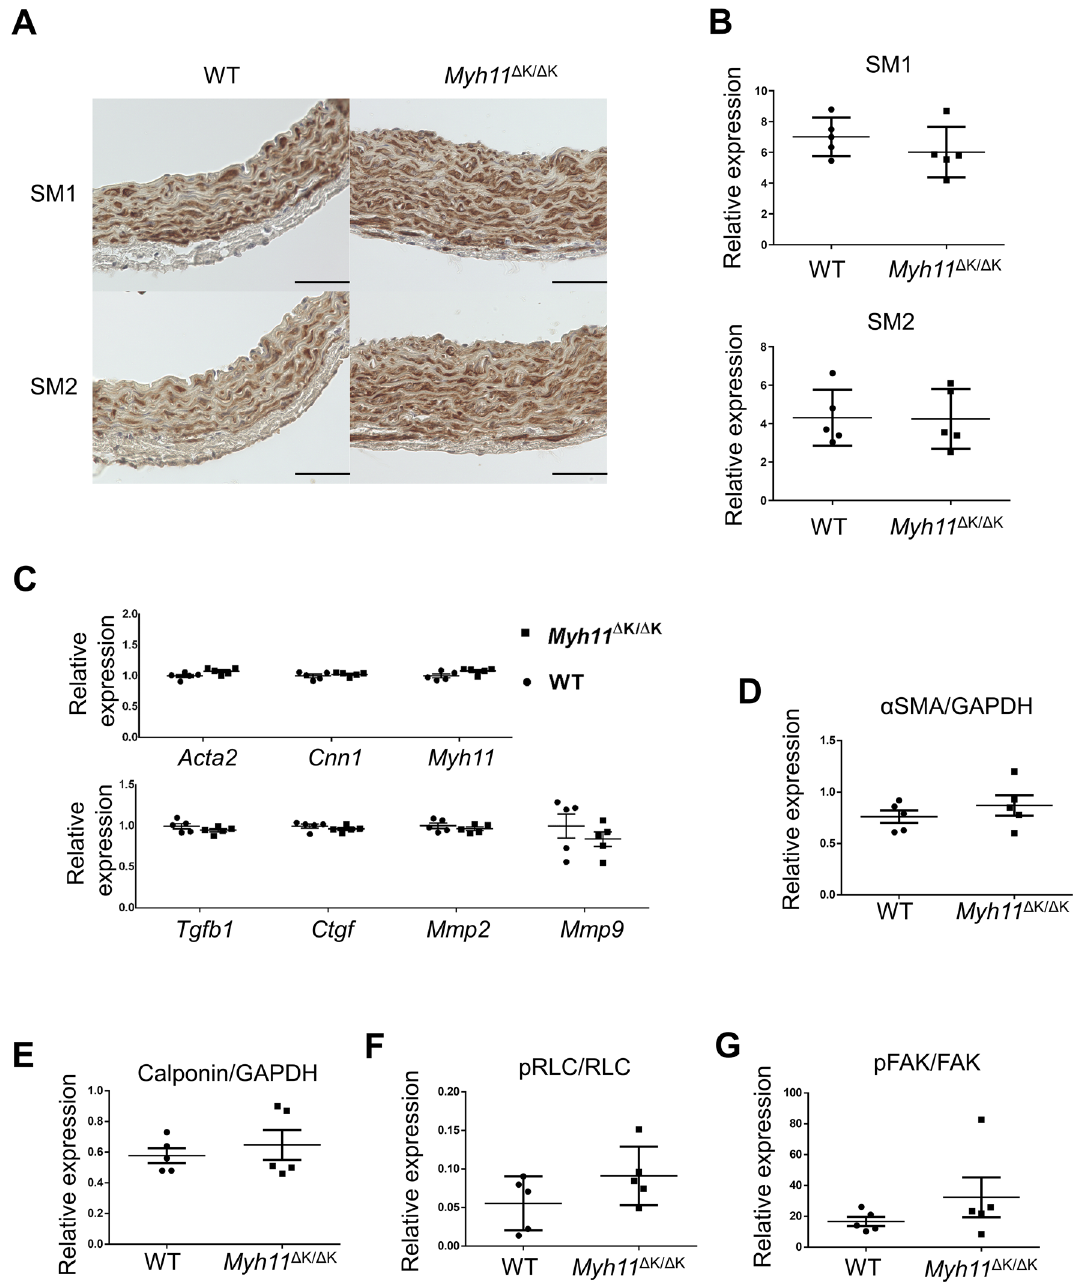
Figure 6. Expression and phosphorylation of proteins in Myh11 ∆K/∆K+ aortas. (A) Immunostaining for SM1 and SM2 showed no obvious differences in expressions and distributions between the WT and Myh11 ∆K/∆K ascending aortas (scale bars = 50 µm, × 400). (B) Densitometric analysis of the expression of SM1 and SM2 in WT and Myh11 ∆K/∆K aortas. Protein expression levels were normalised to that of GAPDH (n = 5). The Mann–Whitney U test showed that the difference was not statistically significant. (C) RT-qPCR analysis of Acta2 , Cnn1 , Myh11 , Tgfb1 , Ctgf , Mmp2 and Mmp9 mRNA isolated from thoracic aortas of WT and Myh11 ∆K/∆K+ mice at 12 weeks of age. Gene expression levels were normalised to Gapdh . Gene expression did not significantly differ between the WT and Myh11 ∆K/∆K aortas (WT vs Myh11 ∆K/∆K+ n = 5, Acta2 ; p = 0.11, Cnn1 ; p = 0.73, Myh11 ; p = 0.06, Tgfb1 ; p = 0.41, Ctgf ; p = 0.29, Mmp2 ; p = 0.53 and Mmp9 ; p = 0.41). (D) Densitometric analysis of the expression of αSMA in WT and Myh11 ∆K/∆K aortas. Protein expression levels were normalised to that of GAPDH (n = 5). The Mann–Whitney U test showed that the difference was not statistically significant. (E) Densitometric analysis of the expression of calponin in WT and Myh11 ∆K/∆K aortas. Protein expression levels were normalised to that of GAPDH (n = 5). The Mann–Whitney U test showed that the difference was not statistically significant. (F) Densitometric analysis of the ratio of phosphorylated myosin regulatory light chain (RLC) to total RLC expression in WT and Myh11 ∆K/∆K aortas (n = 5). The Mann–Whitney U test showed that the difference was not statistically significant (p = 0.222). (G) Densitometric analysis of the ratio of phosphorylated focal adhesion kinase (FAK) expression to total FAK expression (n = 5). The Mann–Whitney U test showed that the difference was not statistically significant (p =